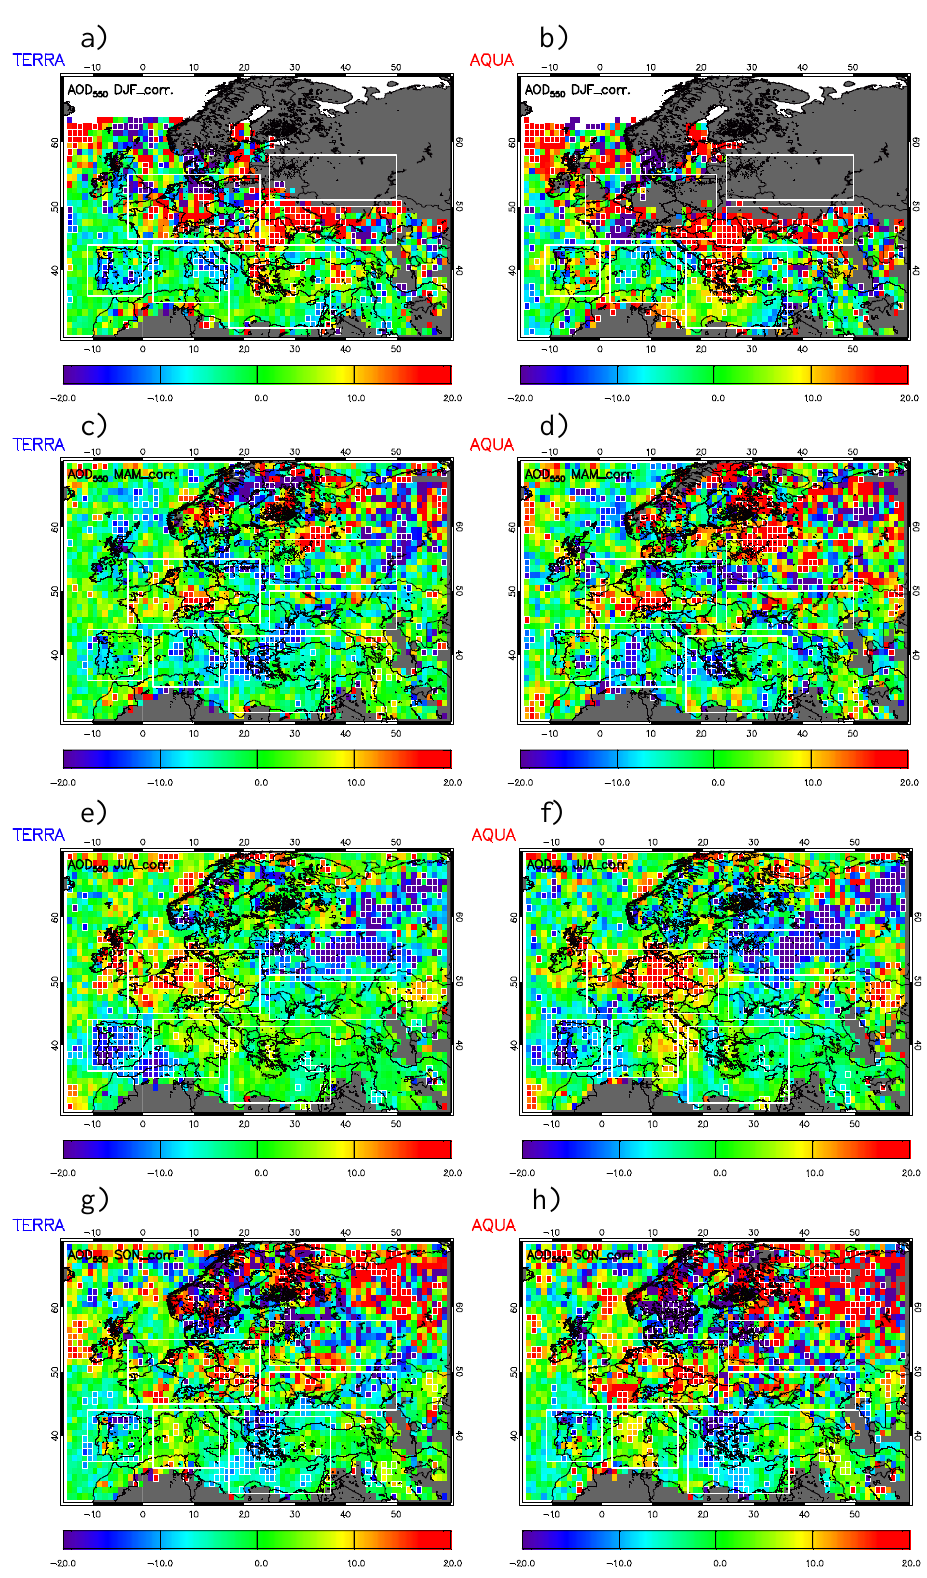
Fig. 5. Seasonal WCI patterns calculated from MODIS AOD 550 measurements corrected with the ± 1000% limit (a) DJF TERRA (February 2000–February 2009), (b) DJF AQUA (July 2002–December 2008), (c) the same as (a) but for MAM, (d) the same as (b) but for MAM, (e) the same as (a) but for JJA, (f) the same as (b) but for JJA, (g) the same as (a) but for SON, (h) the same as (b) but for SON. The grid cells with a statistically significant value at the 90% confidence level according to the two tailed t-test appear with a thin white outline. The 6 regions of interest are marked with a thick white outline in all the